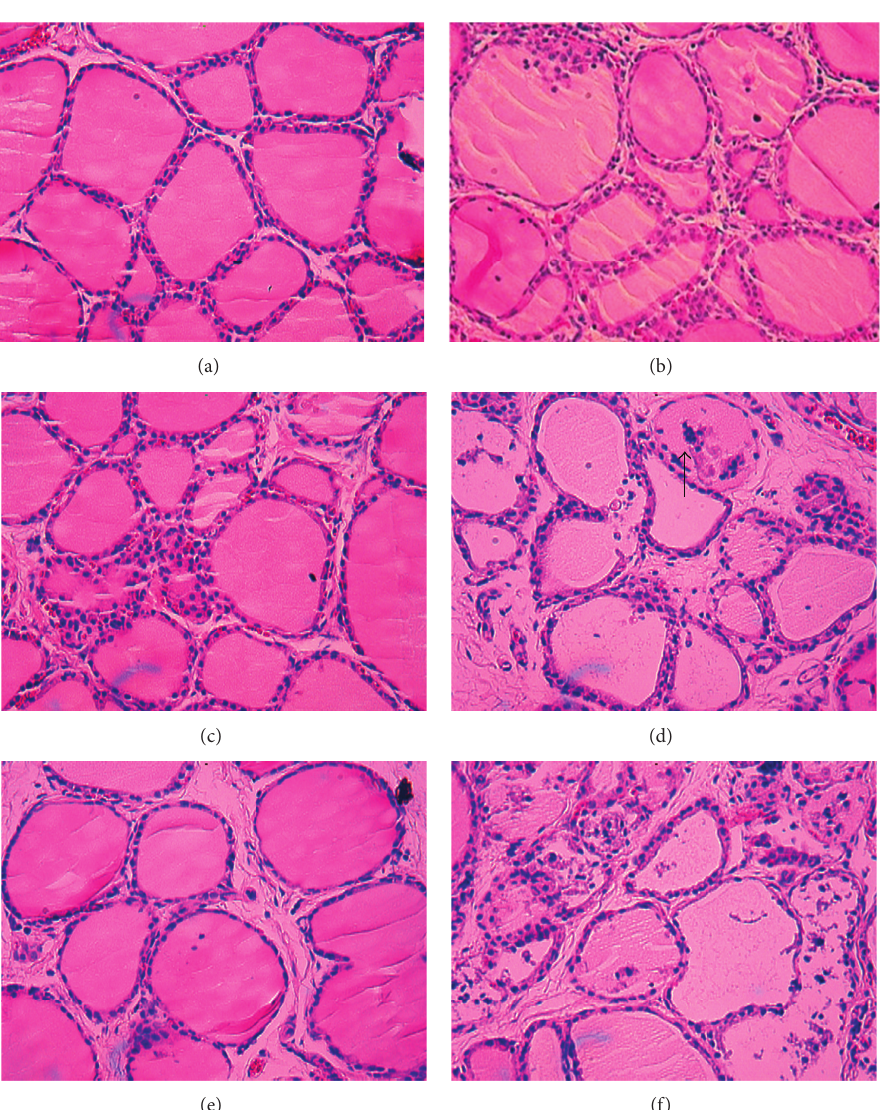
Figure 2: Histological appearance of rat thyroid tissue. (a) Section of thyroid tissue from the normal group, showing absence of lymphocyte cell infiltration ( − ). (b) Section of thyroid tissue from the TG group (+). (c) Section of thyroid tissue from the HI group (+). (d) Many mononuclear cells infiltrating the thyroid tissue from the HI+TG group ( ++ ). Arrows point to lymphocyte cell infiltration. (e) Section of thyroid tissue from the HII group, showing diffuse thyroidization ( ++ ). (f) Section of thyroid tissue from the HII+TG group ( +++ ). Original magnification: HE,